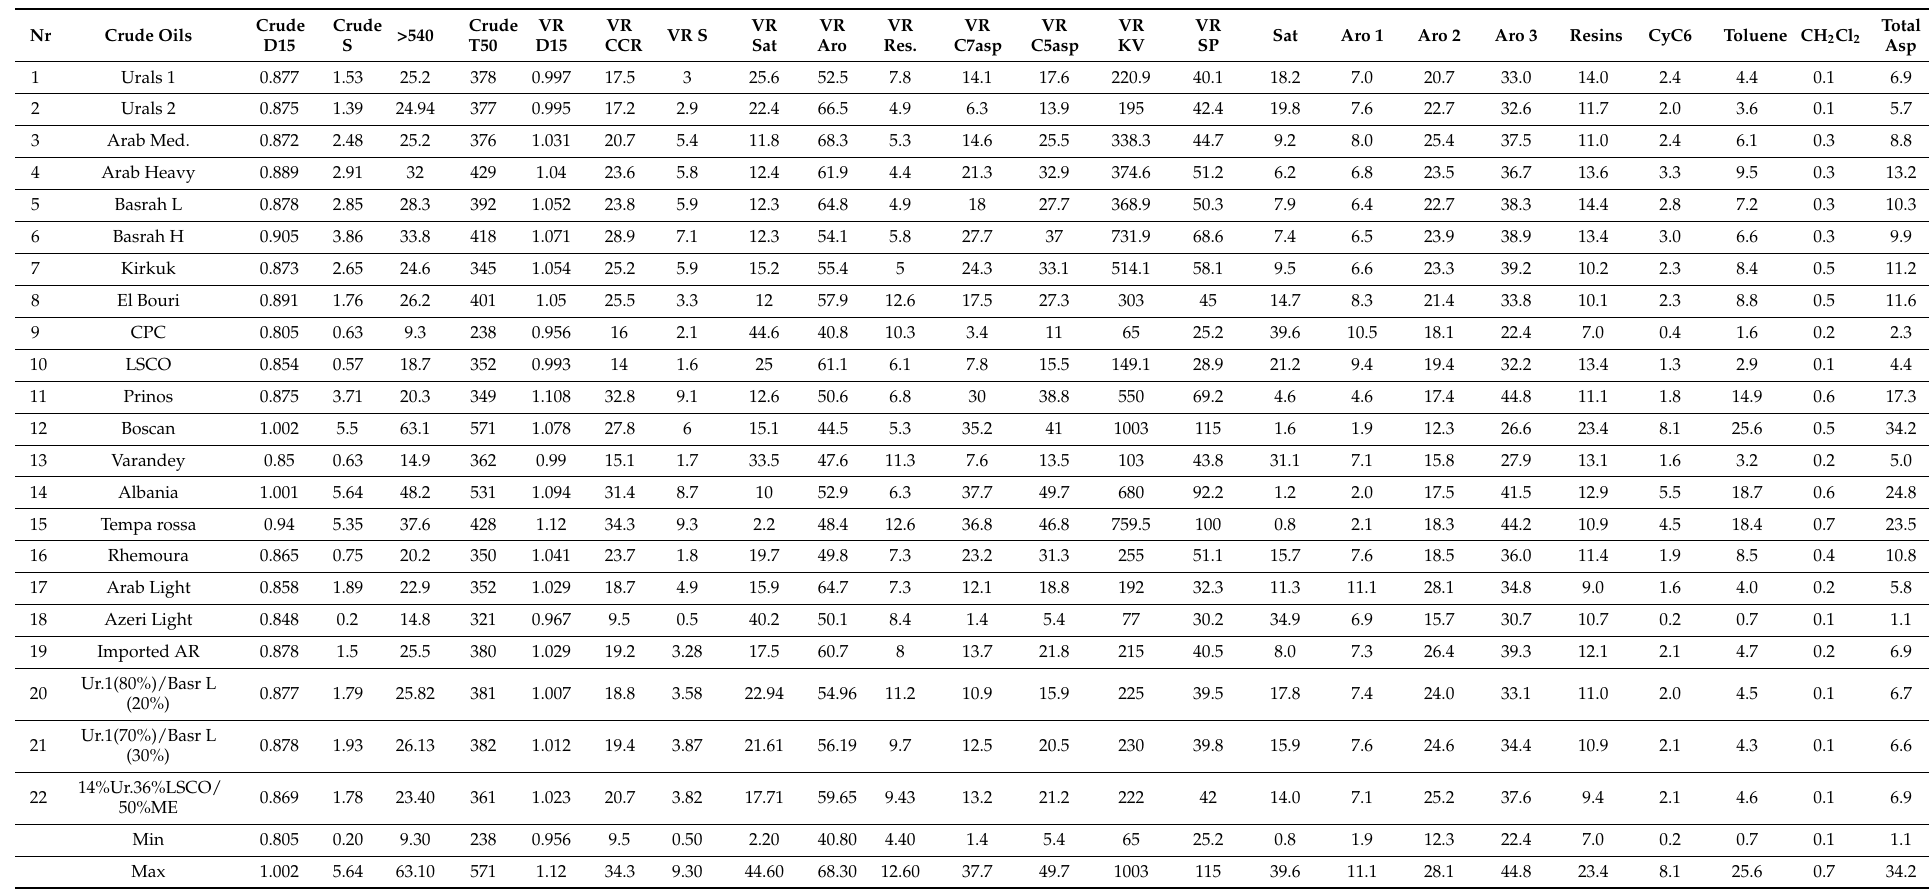
Table 1. Bulk properties of studied crude oils and derived thereof vacuum residue fractions and four and eight fractions SARA composition data of the vacuum